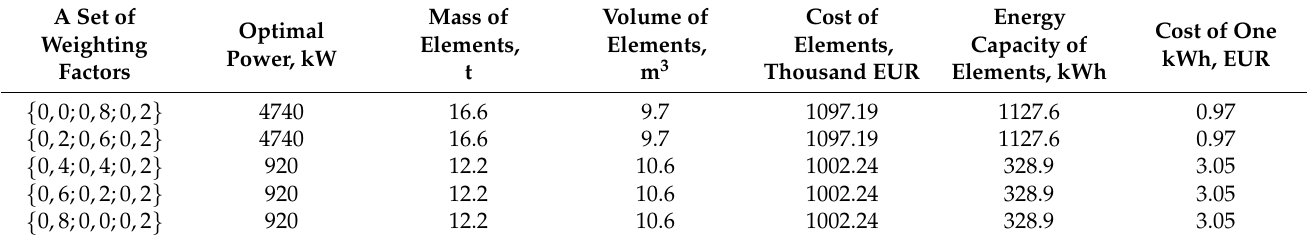
Table 3. Results of calculations of ES parameters with LTO elements and